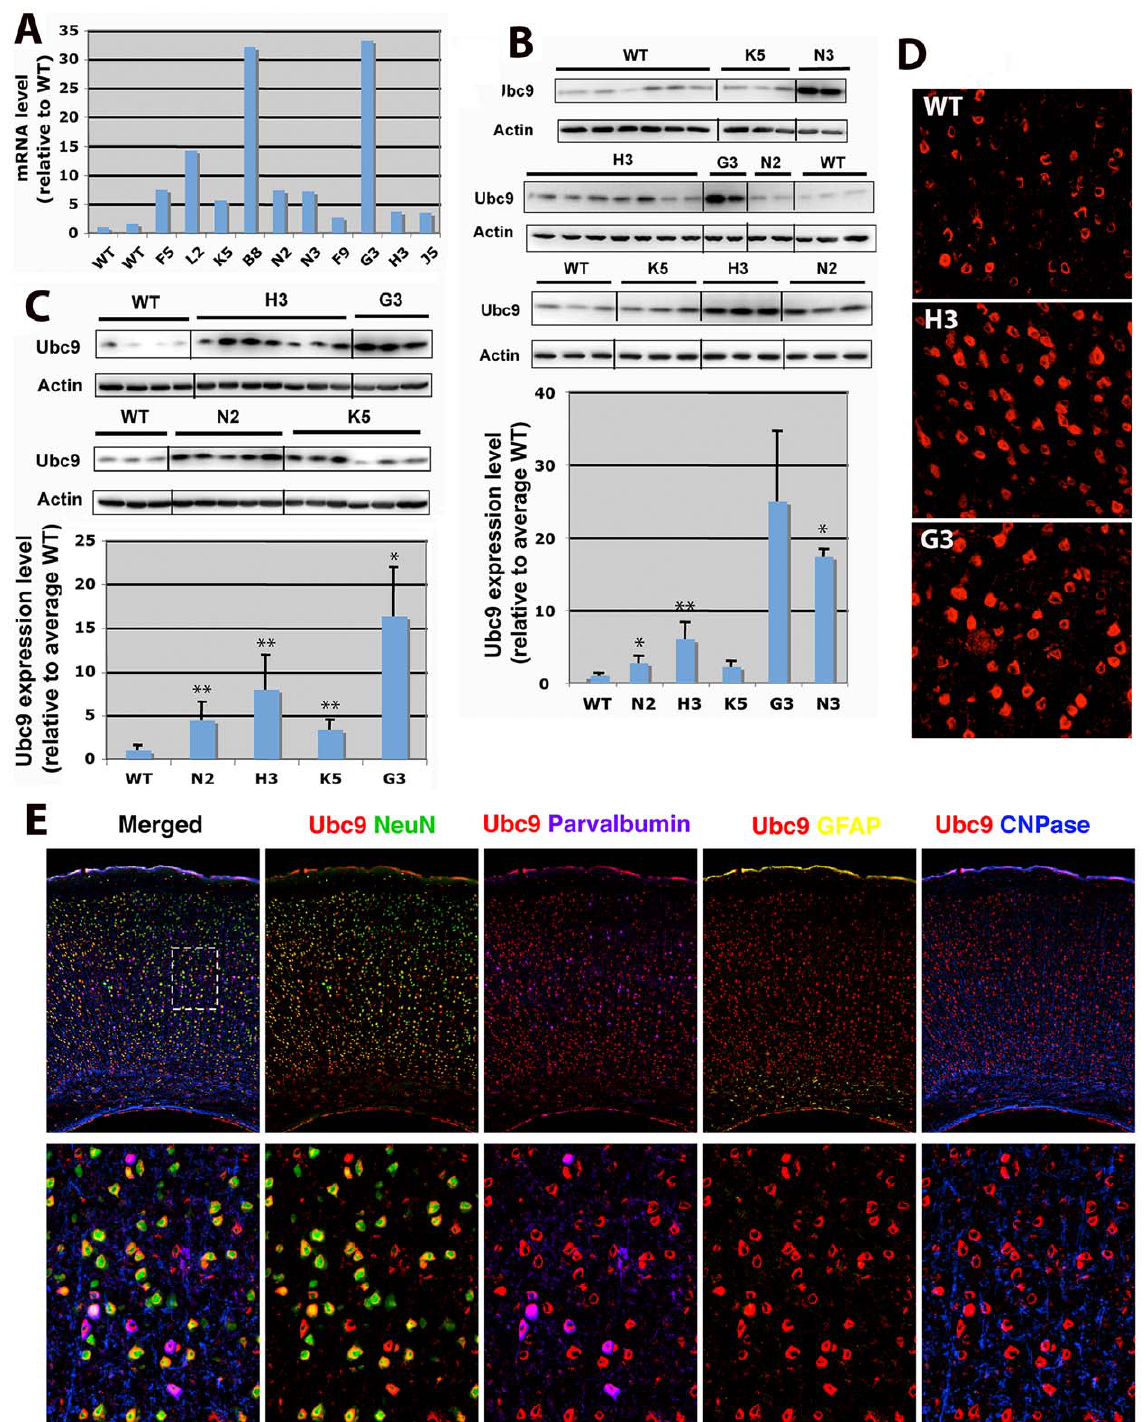
Figure 1. Ubc9 expression levels in WT and Ubc9 transgenic mice. (A) Ubc9 message levels in tail sample from WT and Ubc9 transgenic founder lines (first generation) were measured in triplicate by real-time PCR. The average Ubc9 mRNA level in each animal was normalized by its tubulin mRNA level and plotted relative to the WT average level. (B) Ubc9 protein levels in tail samples. Protein (20 m g) isolated from tail samples from WT and Ubc9 transgenic mice was analyzed by Western blot (upper panel). Intensities of Ubc9 protein bands were normalized to actin and plotted relative to WT average level (lower panel). n=2–10 (mean 6 SD). *P , 0.05, **P , 0.01 (note: G3 n=2 with large SD). (C) Ubc9 protein levels in brain samples. Proteins (20 m g each) isolated from brains of WT and transgenic mice were analyzed by Western blot (upper panel). Intensities of Ubc9 protein bands were normalized to actin and plotted relative to WT average level (lower panel). n=3–7 (mean 6 SD). *P , 0.05, **P , 0.01. (D) Ubc9 expression levels in brain tissue (cerebral cortex, Layer III-external pyramidal region) of WT and Ubc9 transgenic mice (H3, G3). Ubc9 was shown in red. (E) Ubc9 expressing cells in the cerebral cortex of Ubc9 transgenic mouse (line H3). Upper panels show all layers of cerebral cortex, and lower panels show an enlarged region of the Layer III-External pyramidal area (dashed rectangle in the upper merged panel). NeuN (green), a pan-neuronal